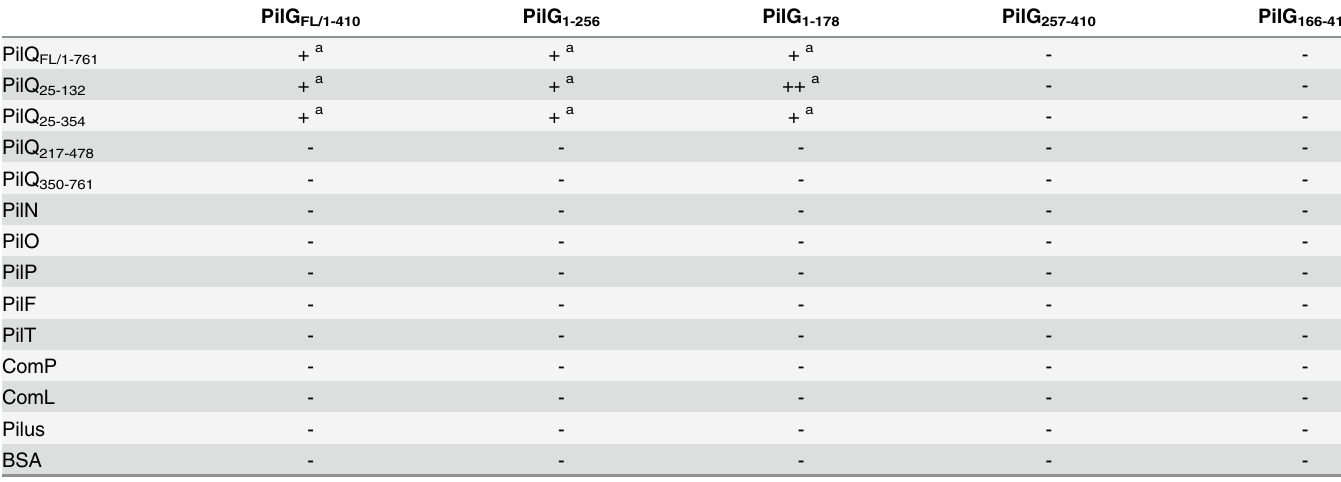
Table 6. Summary of Far-western analysis assessing the interaction between PilG and other pilus biogenesis proteins. The “ + ” refers to positive and the “ - ” refers to no protein-protein interaction